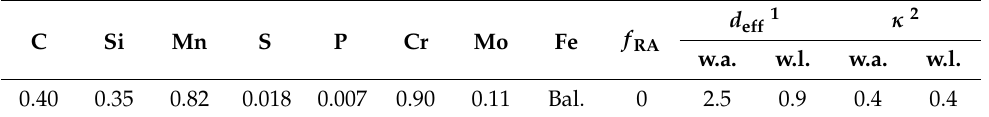
Table 1. Chemical composition (in wt %) of the investigated 42CrMo4 steel; volume fraction of retained austenite ( f RA , in %), effective grain size ( d eff , in µ m) and aspect ratio ( κ , in -) of lath-shaped units in 42CrMo4 steel austempered below M S . w.a. refers to weighed by area and w.l. weighed by length,